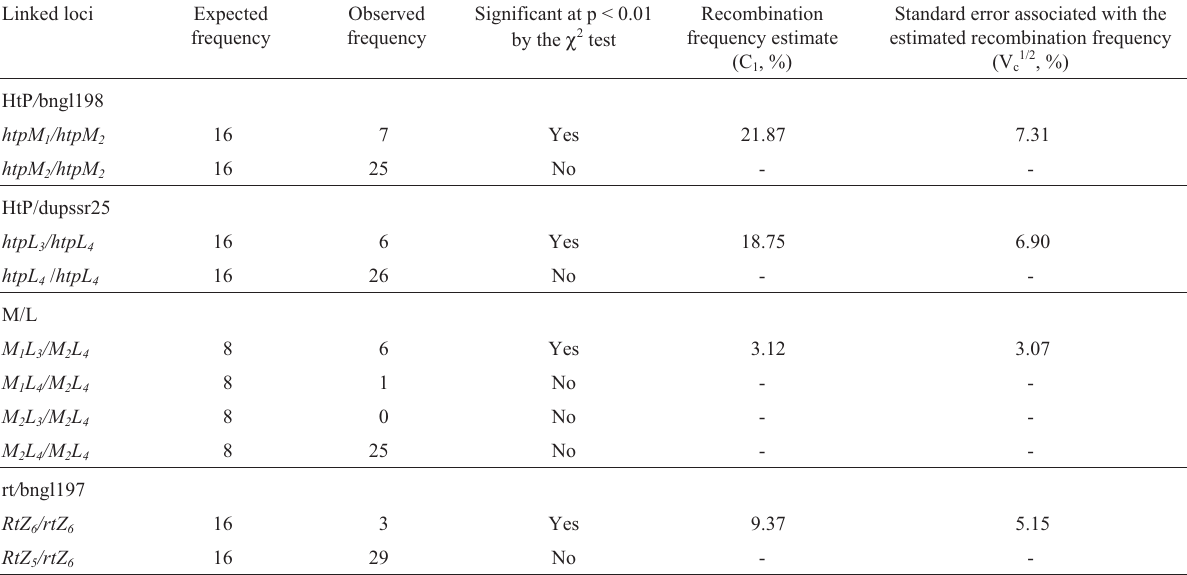
Table 1 - Genetic linkage between HtP , bngl198 (M) , and dupssr25 (L) and between rt and bngl197 in the BC L40 htphtprtrt ) x L40 htphtprtrt ]. Linked